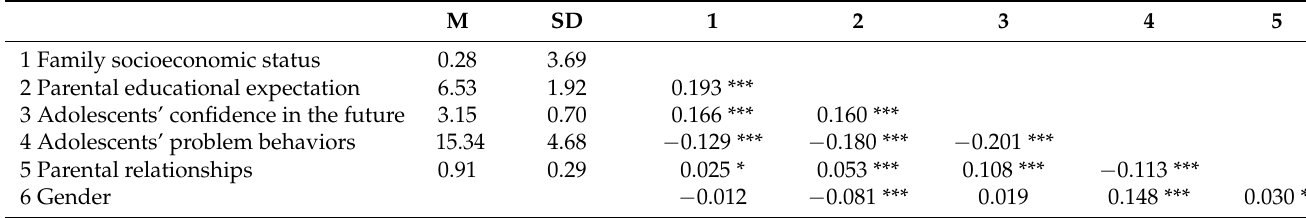
Table 1. Means, standard deviations, and Pearson correlation coefficients of main variables.